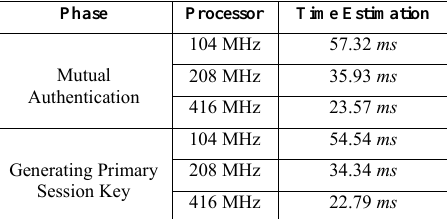
Table 1. Estimation of RFID Tag computation in 1000 Iterations.